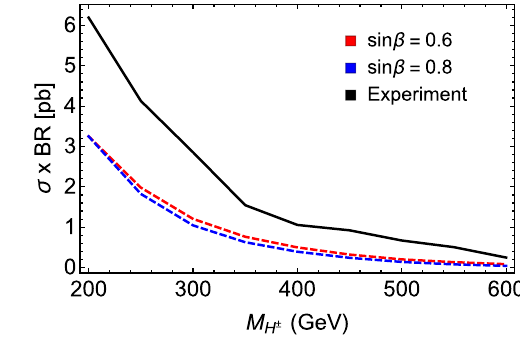
Fig. 13 (Left): The black dashed line shows the maximally allowed branching ratio for t → H ± b from the Tevatron experiments. It is seen that increasing the value of sin β can relax the lower mass bound for